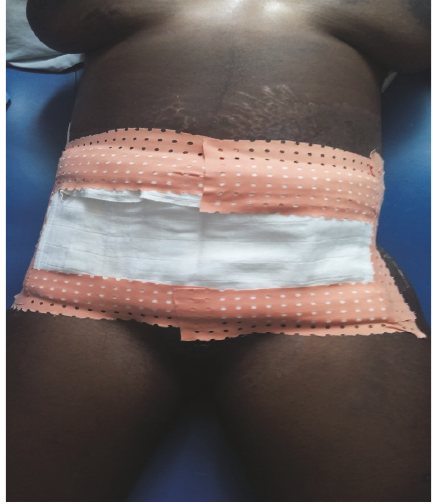
Figure 3: Sterilised baby napkin (diaper) used in covering abdomi- nal defect after each